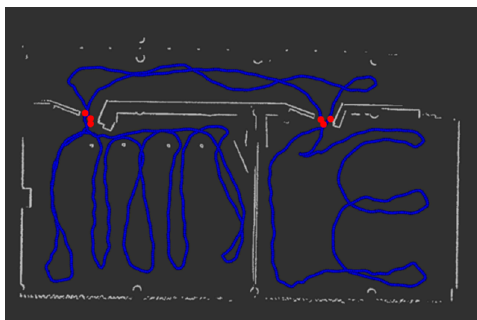
Figure 18. Scenario 3 Room Segmentation: blue points represent the trajectory; red points are those identified as doors.